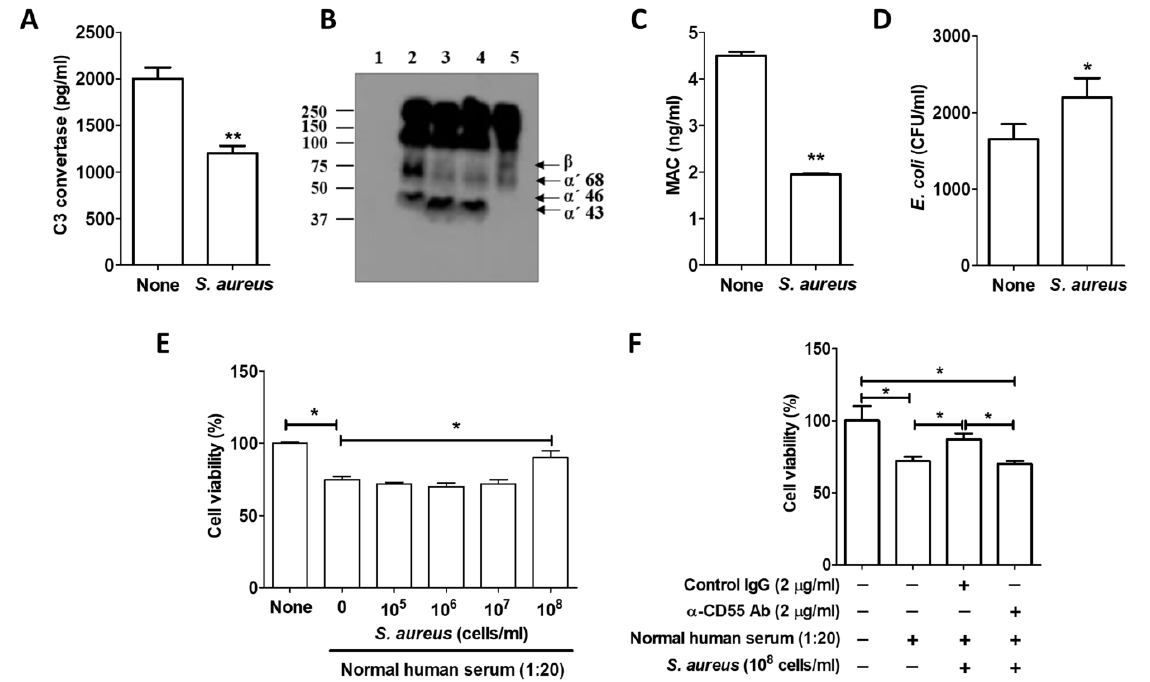
Figure 3. S. aureus infection inhibited the complement system. Mice ( n = 5) were injected with 5 × 10 7 /kg of S. aureus , and blood was collected after 24 h. ( A ) The serum C3C level was examined using a commercially available C3C ELISA kit. ( B ) C3 cleavages were examined by Western blotting. Lane 1: HaCaT cell culture media; Lane 2: NHS (1:20 diluted); Lane 3: NHS incubated with S. aureus ; Lane 4: Coculture media from HaCaT cells and NHS; Lane 5: Coculture media from S. aureus -infected HaCaT cells and NHS. ( C ) The serum MAC level was examined using a commercially available MAC ELISA kit. ( D ) A bactericidal assay was performed with normal mouse sera and S. aureus -infected mouse sera. ( E ) A complement dependent cytotoxicity (CDC) assay was performed with HaCaT cells and NHS. ( F ) A CDC assay was performed with neutralization antibody–treated HaCaT cells and NHS. The data displayed are the mean ± SD. Statistical analysis was conducted with an unpaired two-tailed t test. * p < 0.05, ** p < 0.01 vs. None.